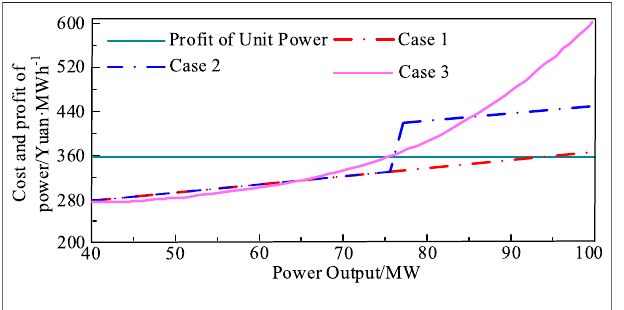
FIGURE 3 | Relationship between unit power comprehensive cost and output of TP.